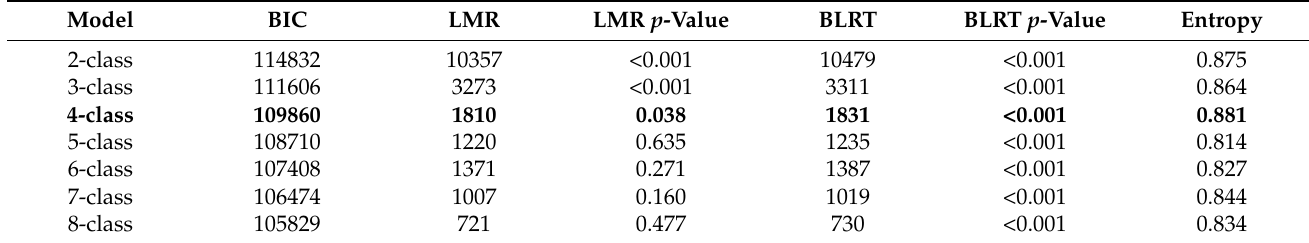
Table 2. Model Fit Indices for Resilience LPA